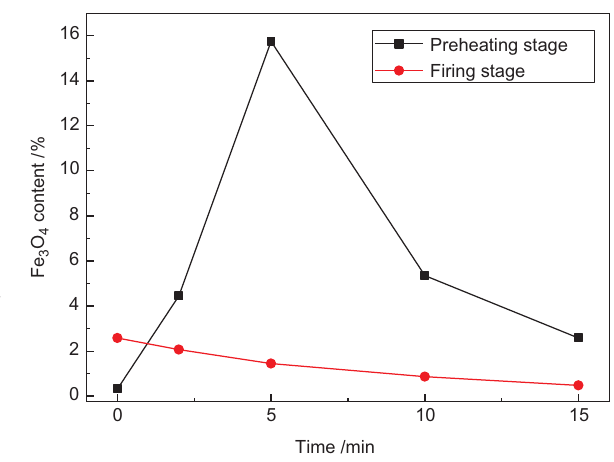
Figure 5: Effect time on Fe 3 O 4 content of pellets containing 1.5% coke fines dosage at different stages (Preheating at 1,050°C and firing at 1,250°C).